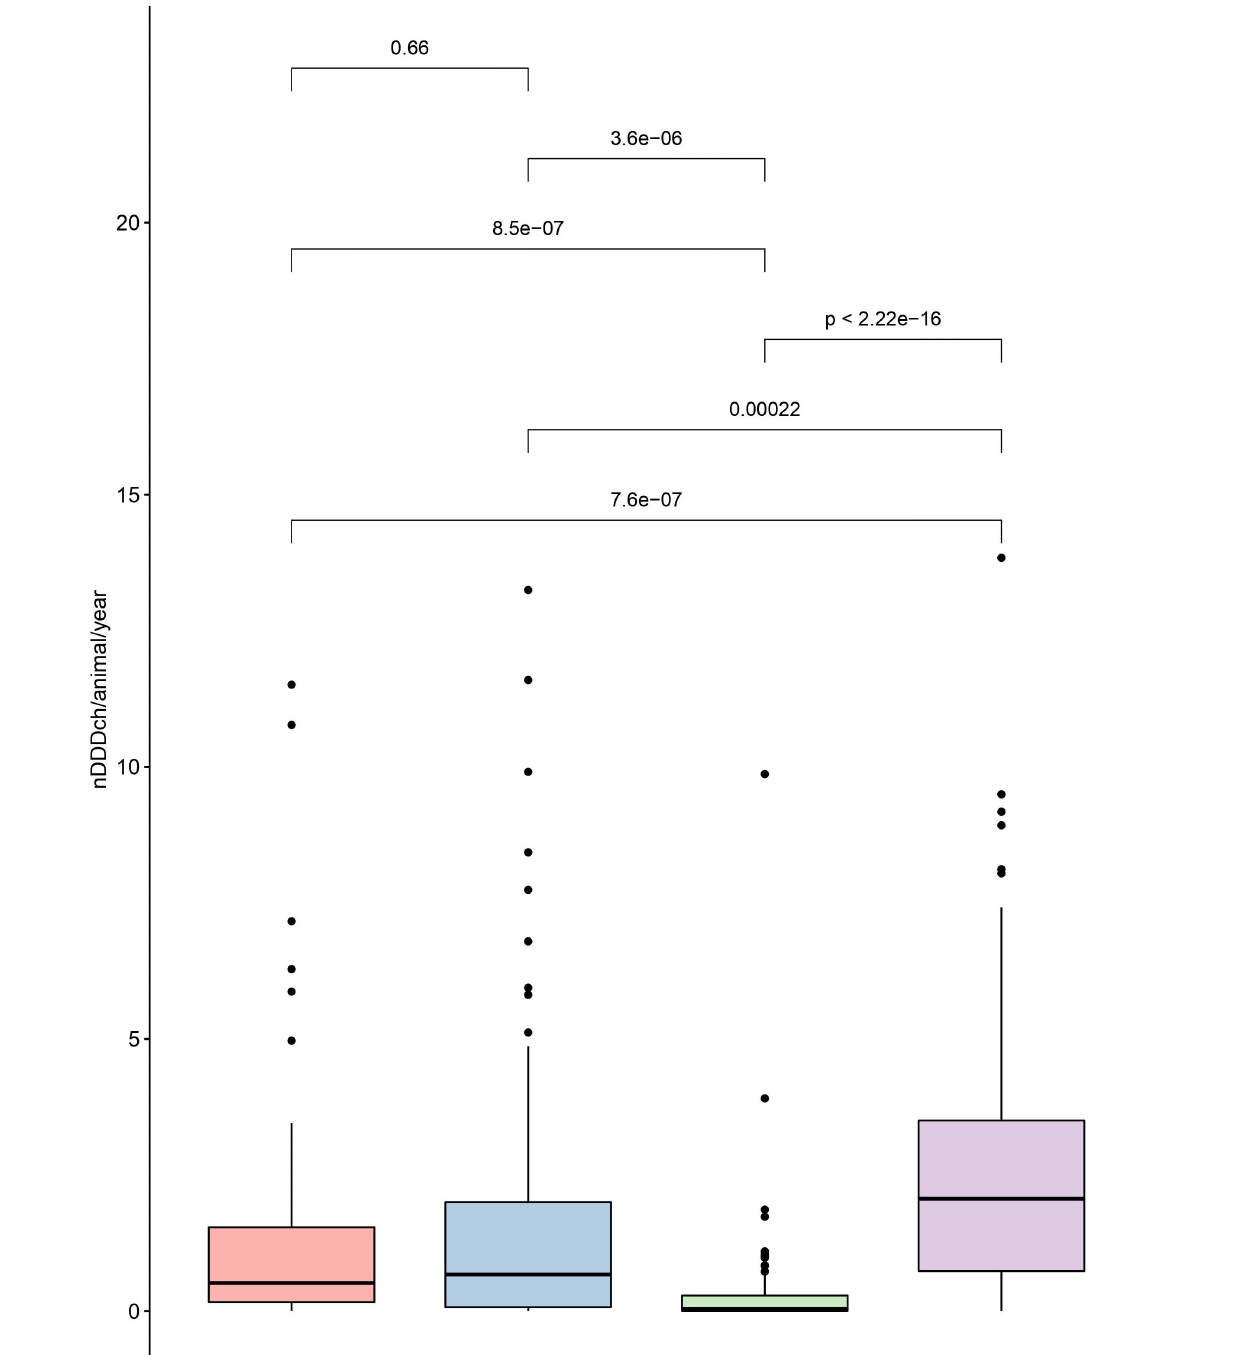
Frontiers in Veterinary Science |